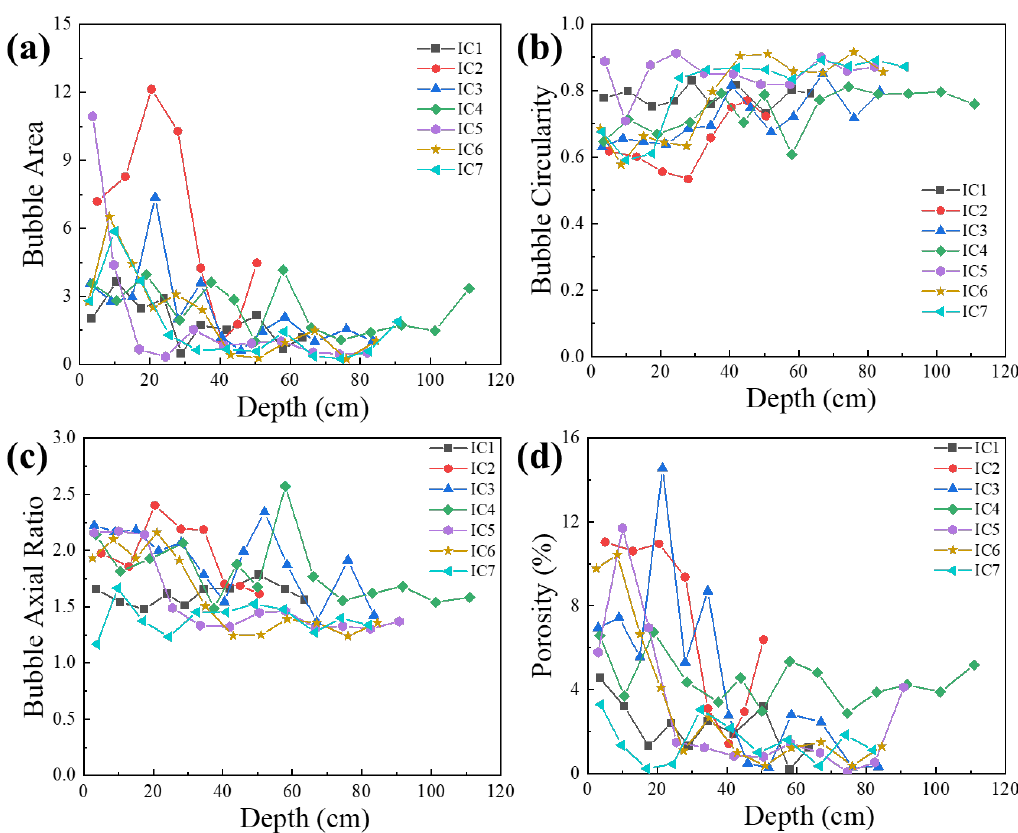
Figure 9. ( a ) Variations of bubble size with depth; ( b ) variations of bubble circularity with depth; ( c ) variations of bubble axial ratio with depth; ( d ) variations of porosity with depth.